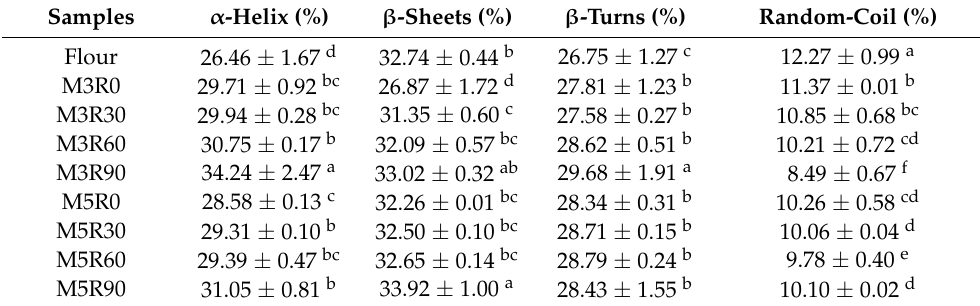
Table 3. Percentage of secondary structures of the GMP. Data are mean values ± standard variation of three replications and different letters indicate a significant difference at p < 0.05. Samples α -Helix (%) β -Sheets (%) β -Turns (%) Random-Coil (%) Flour 26.46 ± 1.67 d 32.74 ± 0.44 b 26.75 ± 1.27 c 12.27 ± 0.99 a M3R0 29.71 ± 0.92 bc 26.87 ± 1.72 d 27.81 ± 1.23 b M3R30 29.94 ± 0.28